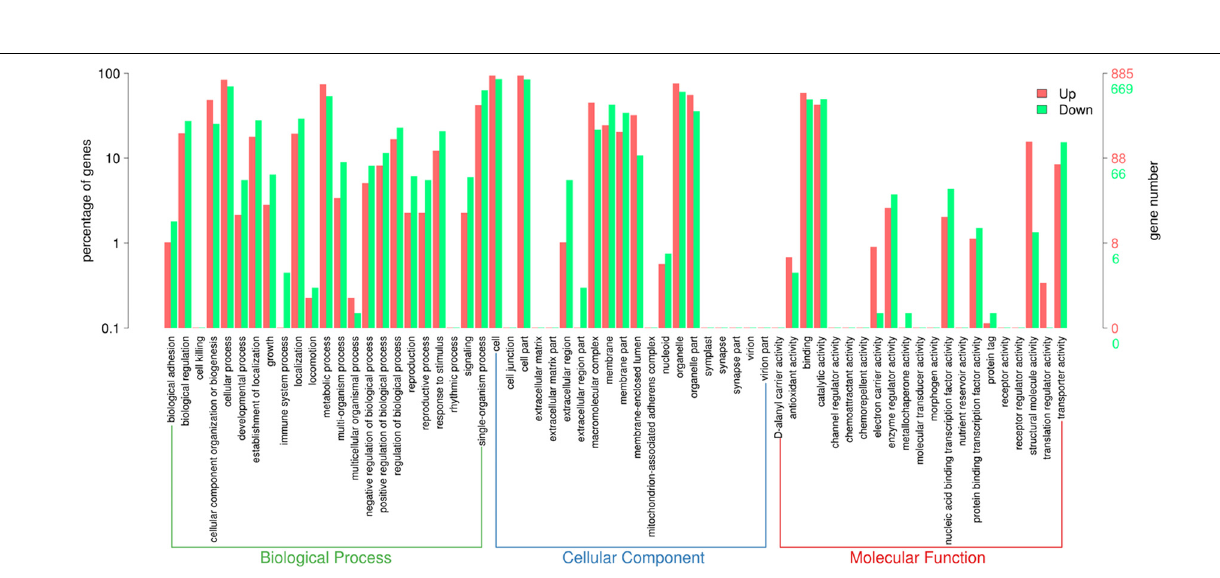
FIGURE 3 | Gene Ontology (GO) term enrichment of differentially expressed genes between sensitive and resistant strains. Three GO categories including molecular function, cellular component, and biological process were used to classify the DEGs. Red represented upregulated genes, and green represented downregulated